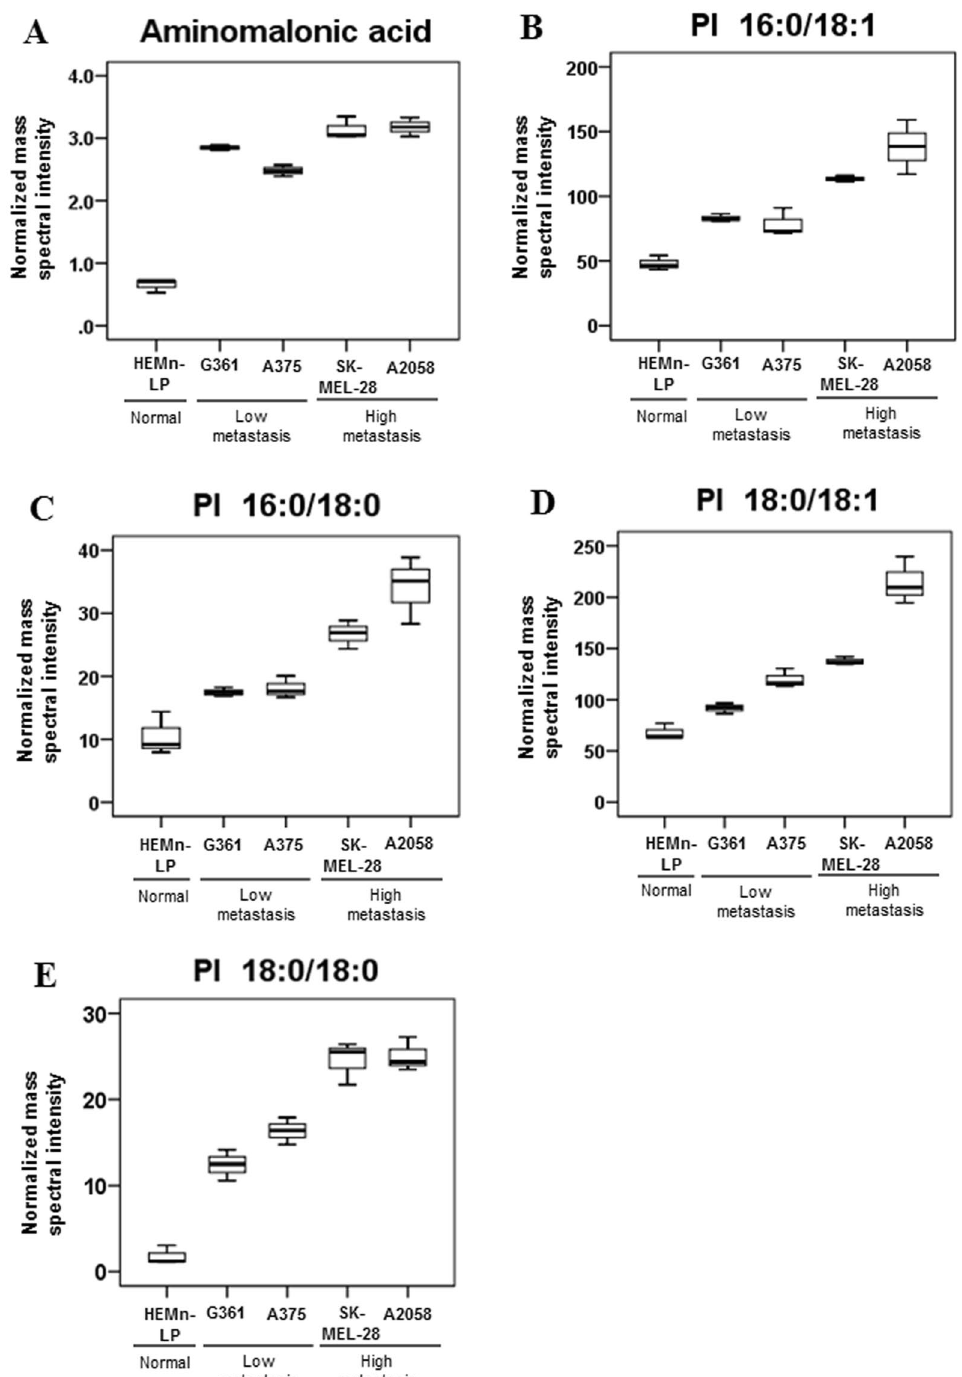
Figure 5. Box plots depicting the relative levels of potential biomarkers, ( A ) aminomalonic acid, ( B ) PI 16:0/18:1, ( C ) PI 16:0/18:0, ( D ) PI 18:0/18:1 and ( E ) PI 18:0/18:0 of normal human melanocytes and melanoma cells with different metastatic potential. Normal human melanocyte (HEMn-Lp), low metastatic melanoma cell lines (A375, G361), and highly metastatic melanoma cell lines (A2058,